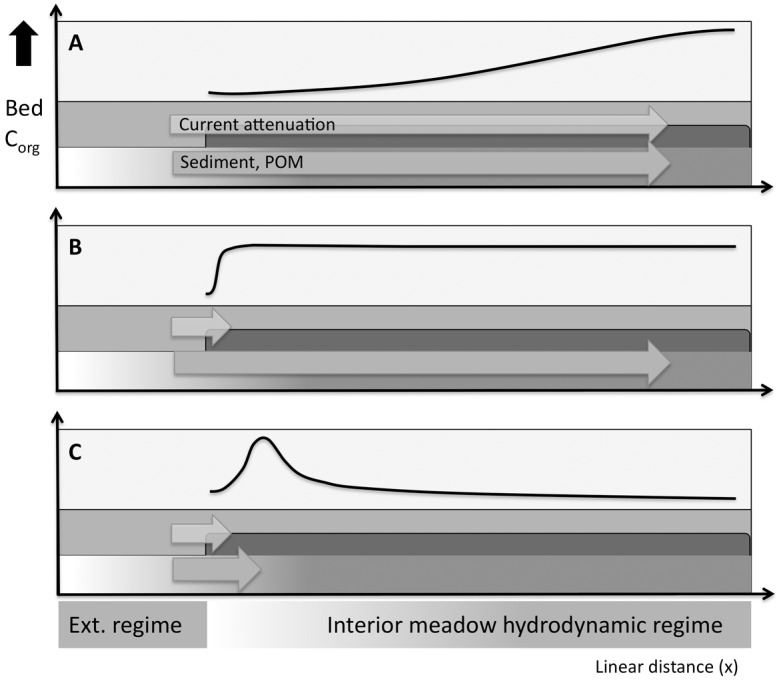
Hypothetical sediment Corg spatial distributions (black lines) relative to a seagrass meadow edge.These hypotheses assume (A) increasing current attenuation with distance into the meadow, (B) attenuation over a short distance and high suspended sediment availability, and (C) attenuation with low suspended sediment availability.